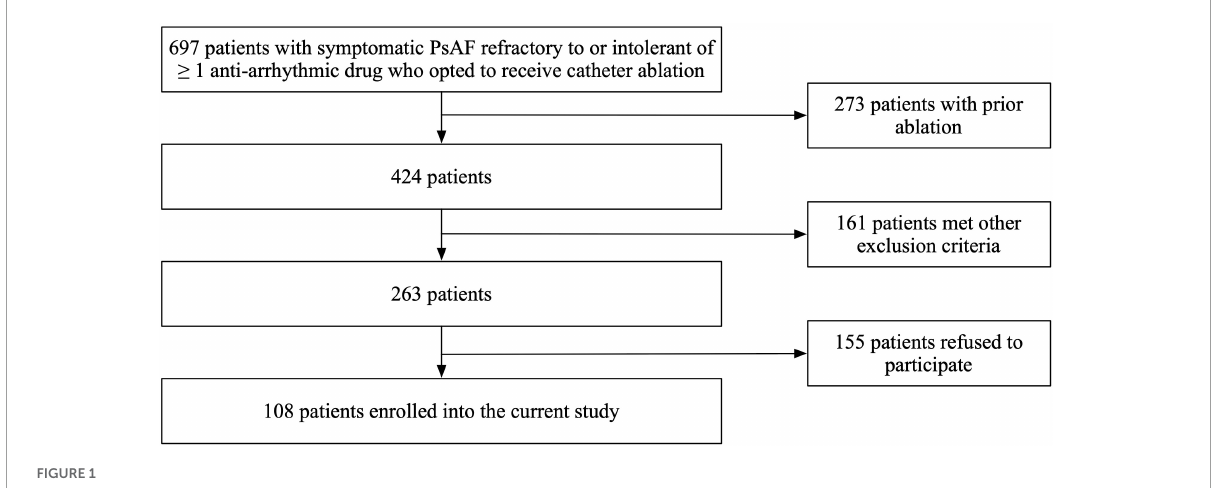
FIGURE1 Flow chart of the enrollment